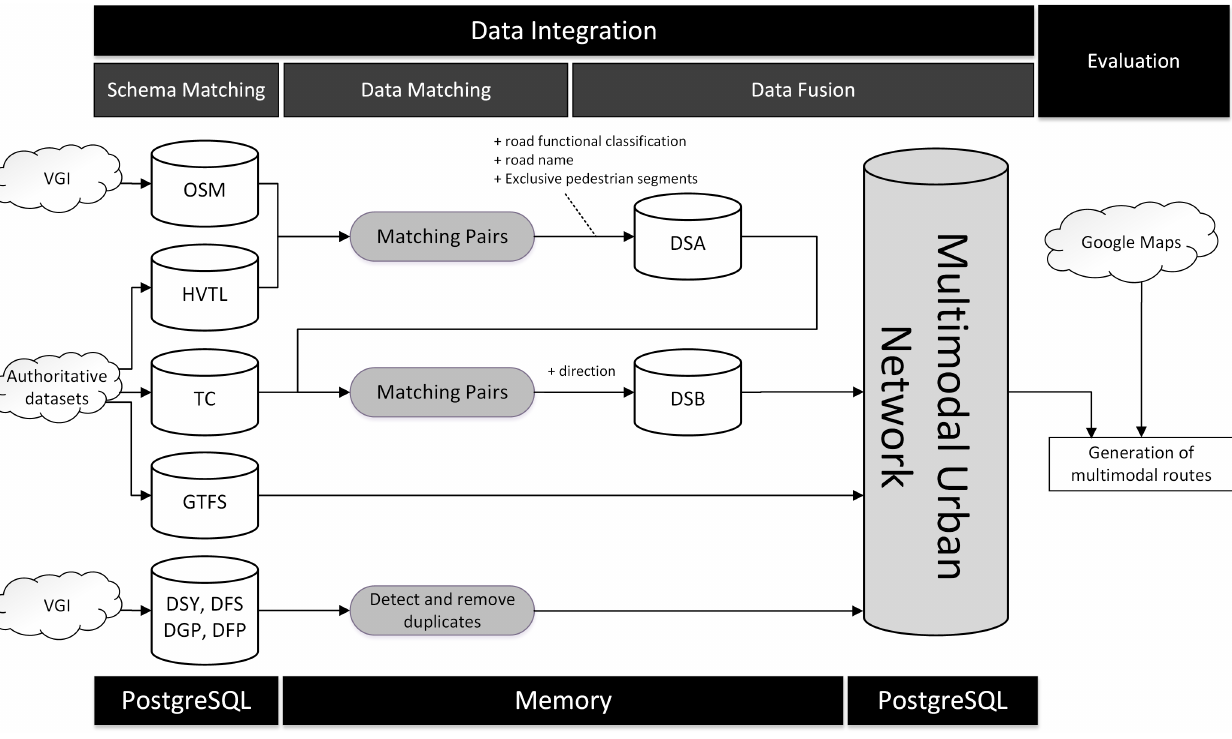
Figure 5. Case study